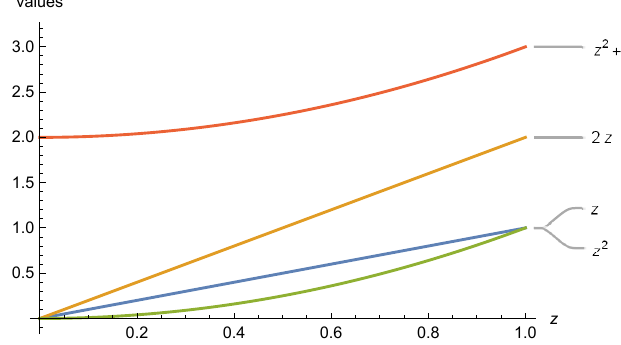
Figure 1. The graph shows the validity of CR -order relations.